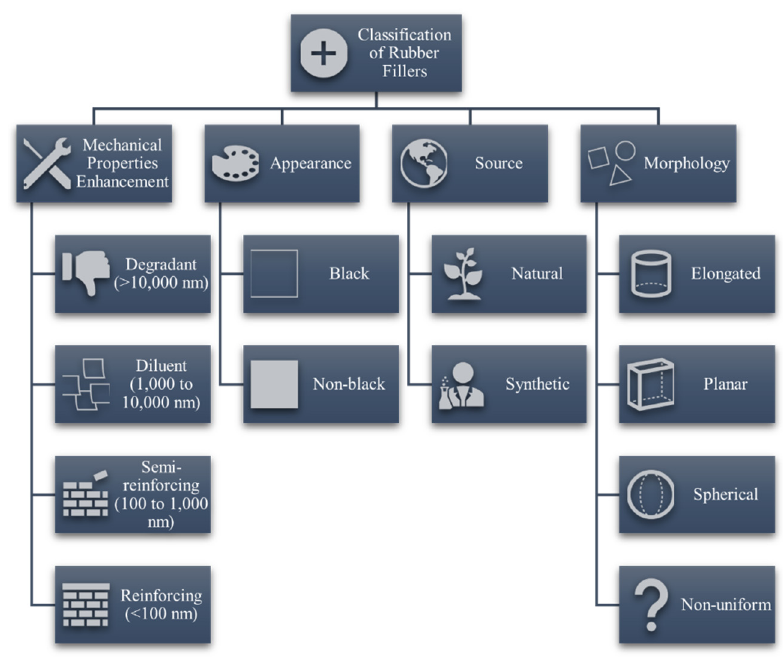
Figure 2. General classification of fillers for rubber sources.